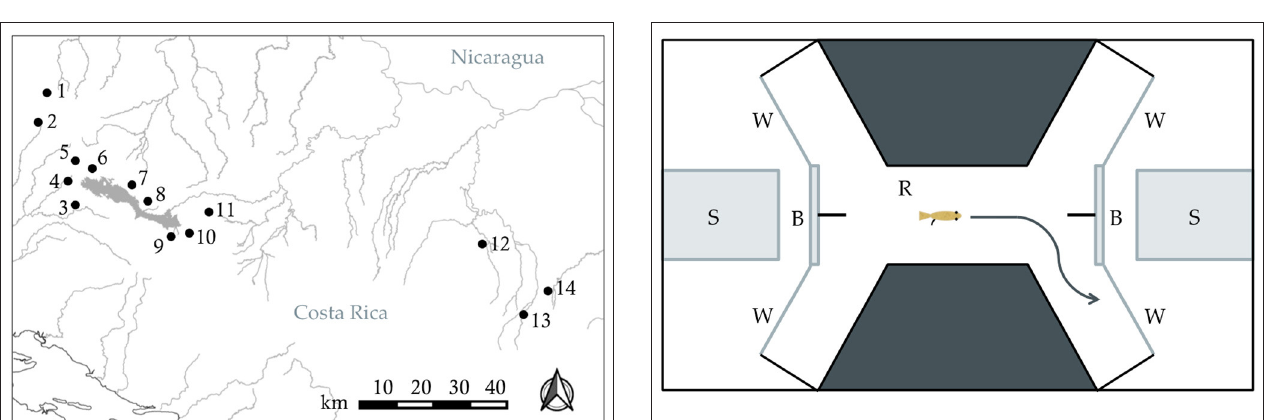
FIGURE 3 | Drawing of the experimental tank used in the detour behavioral assay. (S) The stimulus insert is made of clear glass and used to house the live, physical stimulus. (B) The semi-opaque barrier partially obscures the stimulus from an individual in the raceway area. (W) The viewing window allows an individual to clearly see a stimulus through clear glass. (R) The raceway is where an individual moves toward a stimulus and has the opportunity to make a left or right